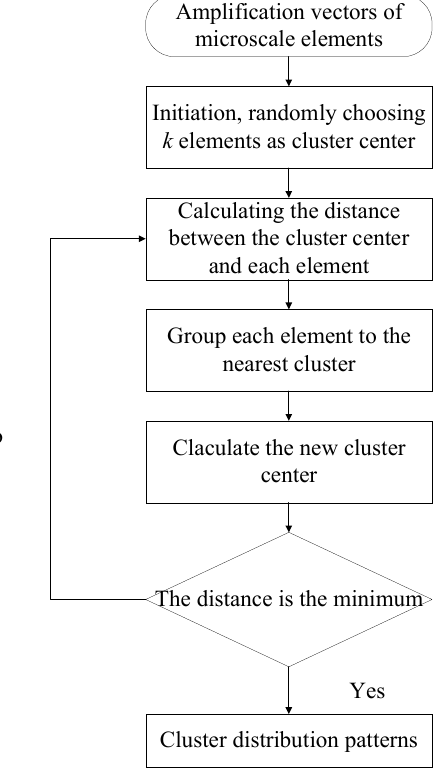
Figure 5. Flowchart for deriving cluster distribution patterns.